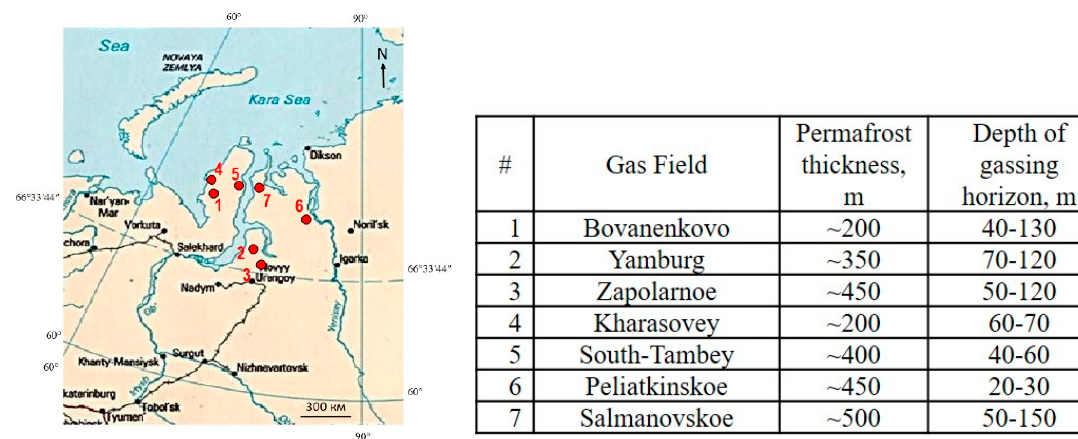
Figure 1. Gas release from shallow permafrost (within 150 m) in gas fields of northern West Siberia.